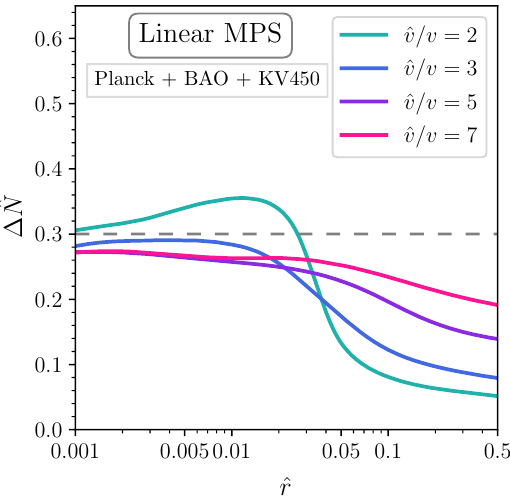
Figure 11. Constraints on the twin parameters obtained using the Planck, BAO, and KV450 datasets, for fixed values of ˆ v/v and using a log prior on ˆ r . The linear matter power spectrum has been used in the fit. All of the parameter space above the lines is excluded at 95% C.L. The simultaneous constraints on all three of the MTH parameters for this choice of datasets are shown in the